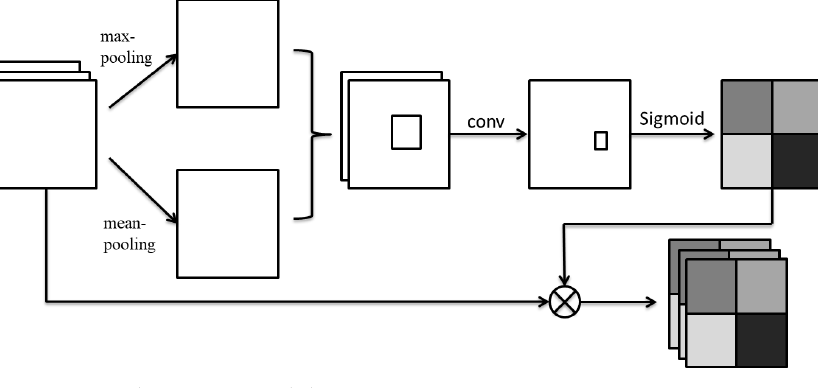
Figure 3. Spatial Attention module.